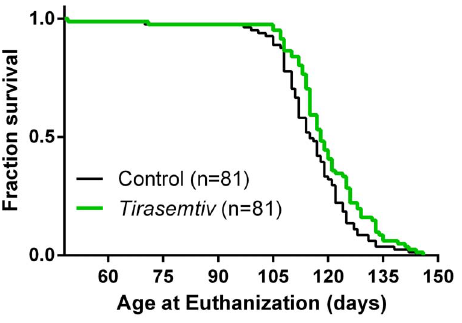
Figure 8. Chronic tirasemtiv exposure had no deleterious effect, and slightly increases survival time of B6SJL-SOD1 G93A mice. Male and female B6SJL-SOD1 G93A transgenic mice fed chow containing tirasemtiv (400 ppm for females or 600 ppm for males) beginning at nine weeks of age survived longer to a humane endpoint compared to control chow-fed mice (p=0.009; hazard ratio=0.66). Data presented were pooled from blinded studies conducted in B6SJL-SOD1 G93A mice randomized to tirasemtiv or control chow (n=81 female and male mice treated with tirasemtiv ; n=81 control female and male mice).